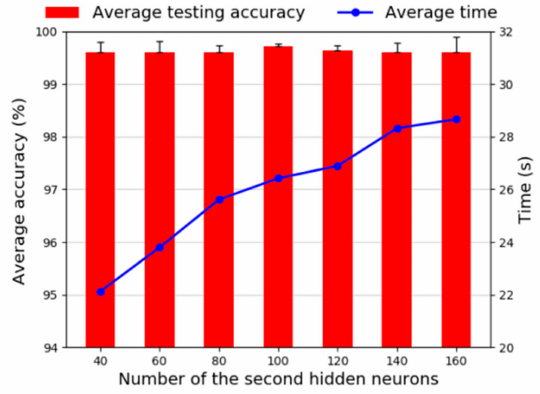
Figure 14. Diagnosis accuracy of neurons number in the second layer.